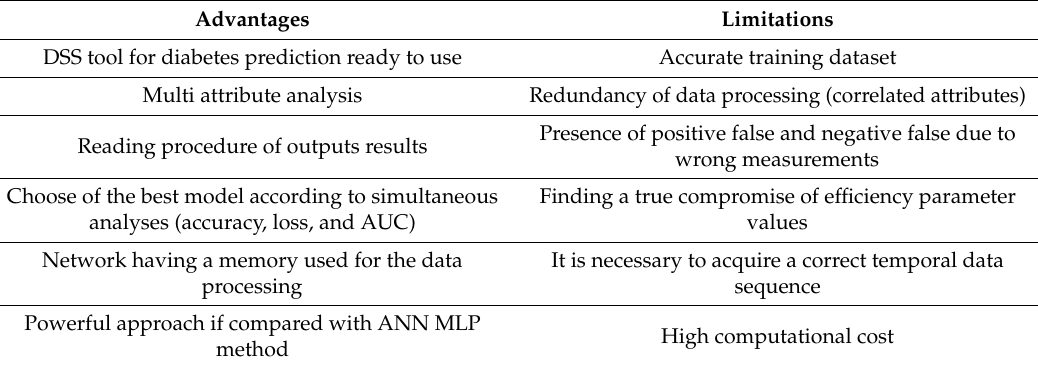
Table 7. Limitations and advantages of the proposed